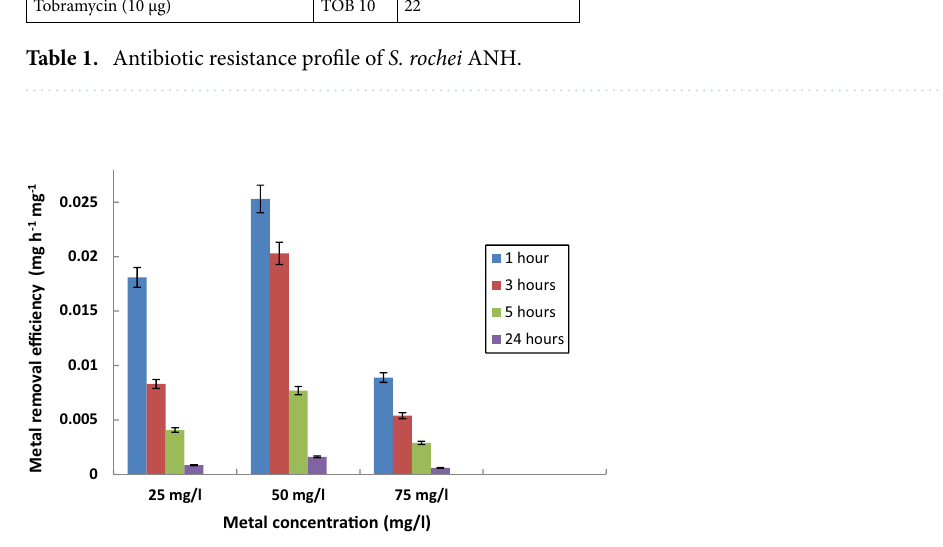
Figure 2. Effect of initial Cr 6+ concentration on the metal removal efficiency by S. rochei ANH at different time intervals. Bars represent standard deviation